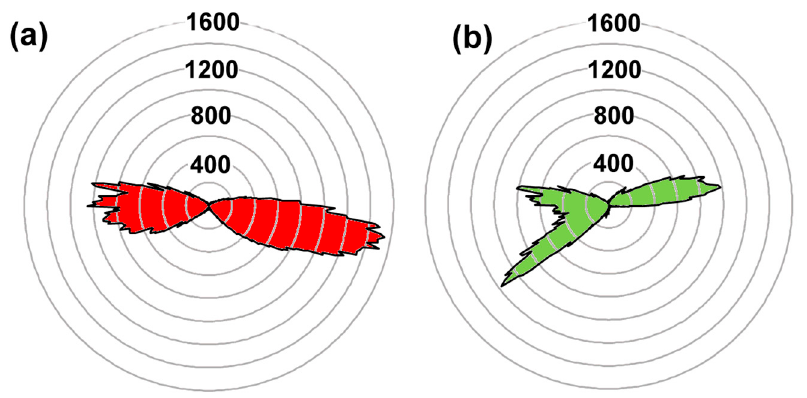
Figure 2. ( a ) Wind vector or metres of wind run over the 4-day campaign at node L2 and ( b ) node R2. Note: the scale is in metres.